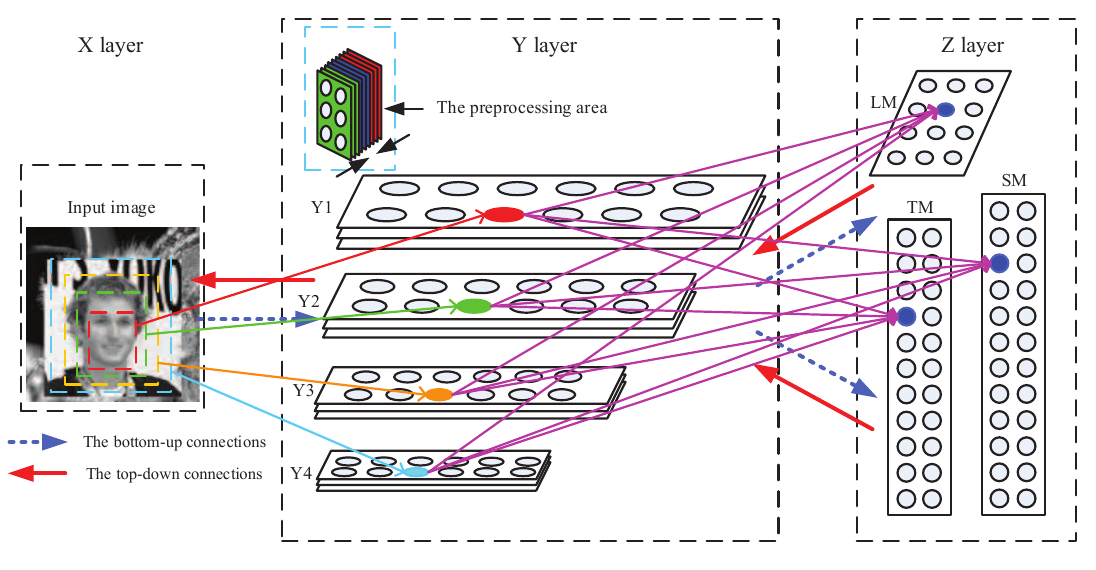
Figure 1: Structure of the WWN-7